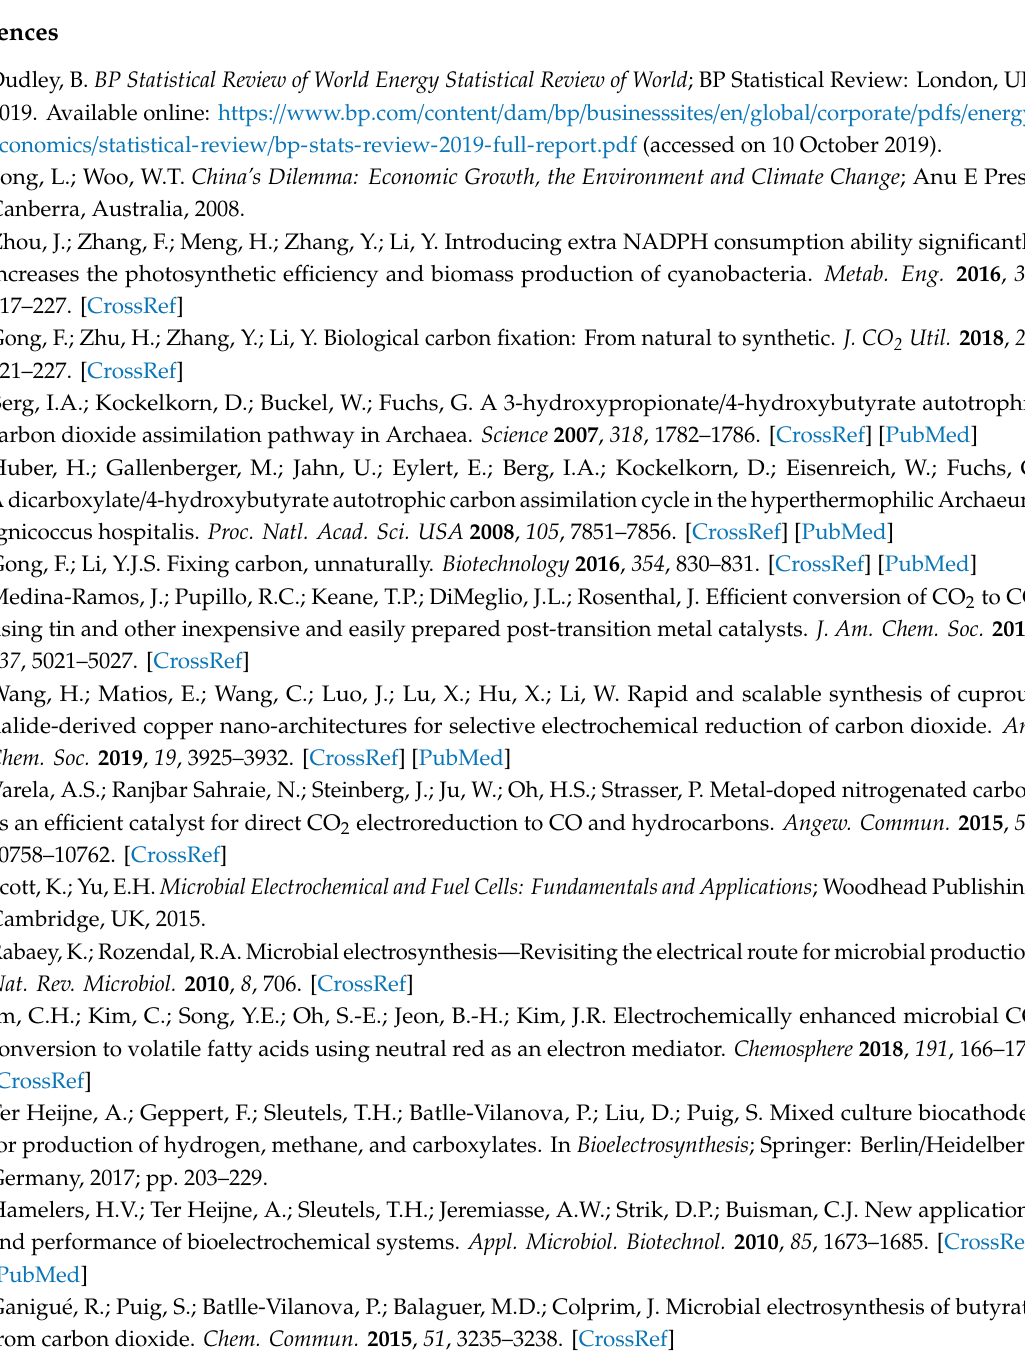
mediators during eight cycles, Figure S5: Acetate production with 7 mM of redox mediators, Figure S6: Cell growth (OD600) profiles at 0.1 mM of redox mediators during electrosynthesis on every eight cycles for 16